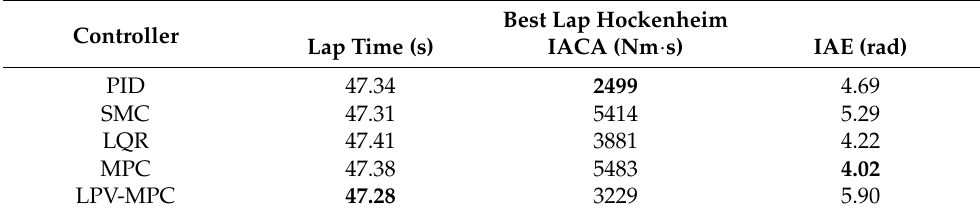
Table 10. Controller performance at